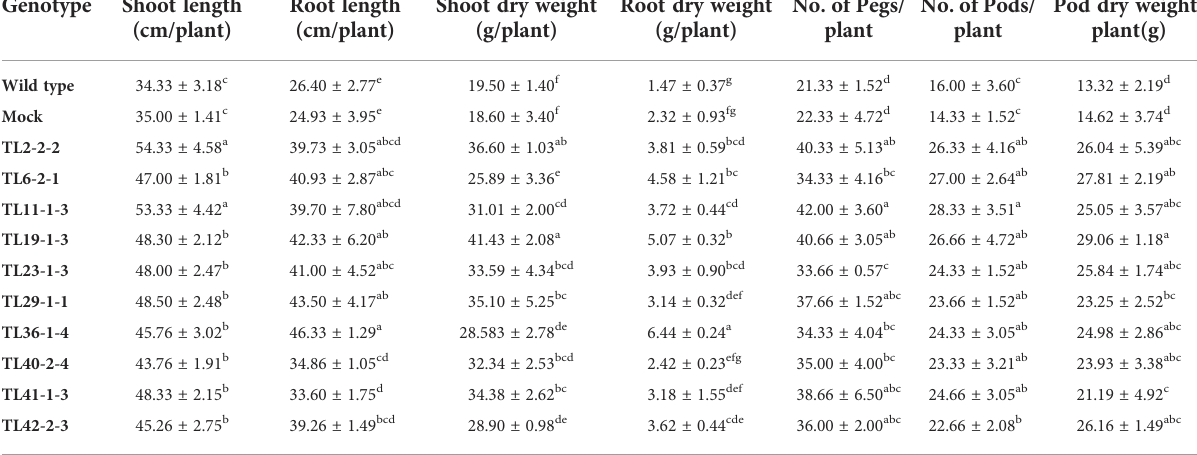
TABLE 1 Growth and yield related parameters in multigene transgenic groundnut plants, wild type and mock plants subjected to drought stress. Genotype Shoot length Root length Shoot dry weight Root dry weight No. of Pegs/ No. of Pods/ Pod dry weight/ (cm/plant) (cm/plant) (g/plant) (g/plant) plant plant